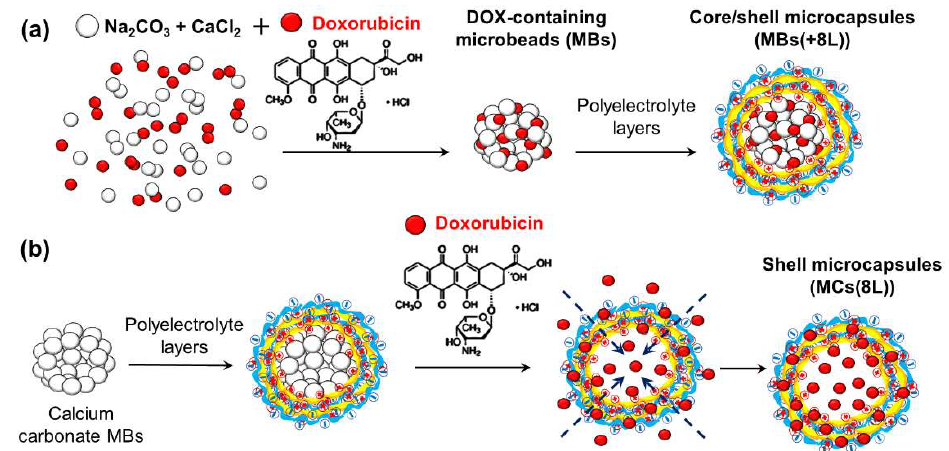
Figure 3. Schematic diagram of the preparation of doxorubicin-containing microcapsules. Two methods were used: ( a ) coprecipitation and ( b ) spontaneous loading. Abbreviations: MBs, microbeads; MCs, microcapsules; DOX, doxorubicin; 8L, polyelectrolyte layers (PAH/PSS) 4 assembled at the microbead surface.